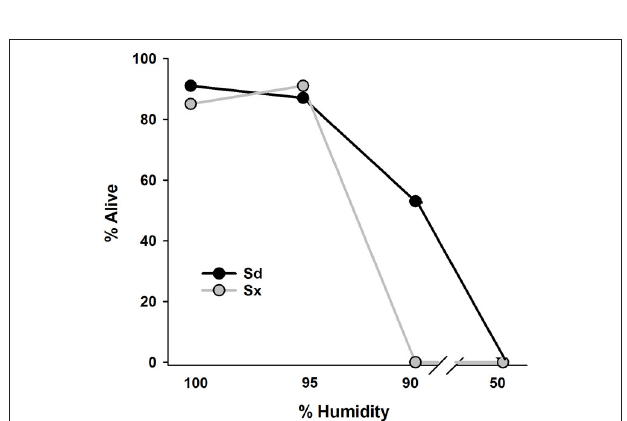
FIGURE 3 | Recovery of two isolates each of infective juvenile Steinernema sp. and S. diaprepesi recovered following 7 d of storage in field capacity (6%) or saturated (18%) sand that originated from a citrus orchard. Proportions were calculated as numbers of nematodes recovered from sand at field capacity divided by the total number of nematodes recovered from soil at both soil moistures. Sd = Steinernema diaprepesi , Sx = Steinernema sp.